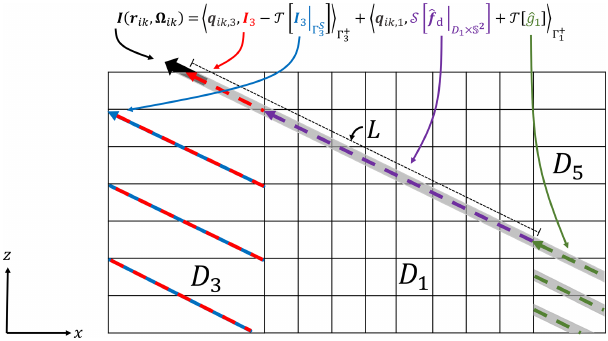
Figure 4. A side view of the system of RTE domains, illustrating the differences in how radiances are calculated during the solution of the RTEs in each domain and during the evaluation of the for- ward model. Consider the calculation of the radiance at the posi- tion r ik and angle (cid:127) ik at the upper boundary of D 3 denoted by the large black arrow. During the solution of the RTE in D 3 , the ra- diance is calculated by integration along the red characteristic that follows the periodic BCs at the edge of D 3 . On the other hand, when the forward model is evaluated, the radiance is calculated through integration along the characteristic denoted by the gray shading which passes through D 3 into D 1 and D 5 . The correspondence be- tween the mathematical expressions for the evaluation of the for- ward model (Eq. 41), in this case, and the graphical illustration are shown. See the main text for additional